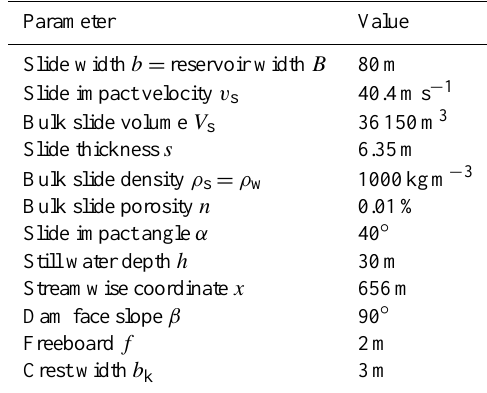
Table 1. Input parameter for the reference geometry based on the water